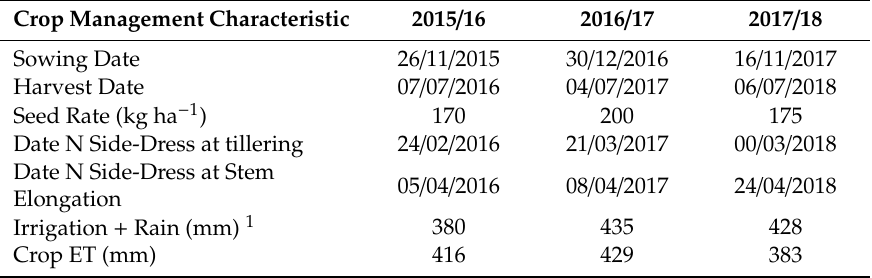
Table 2. General crop management practices of wheat during the three growing seasons. Crop Management Characteristic